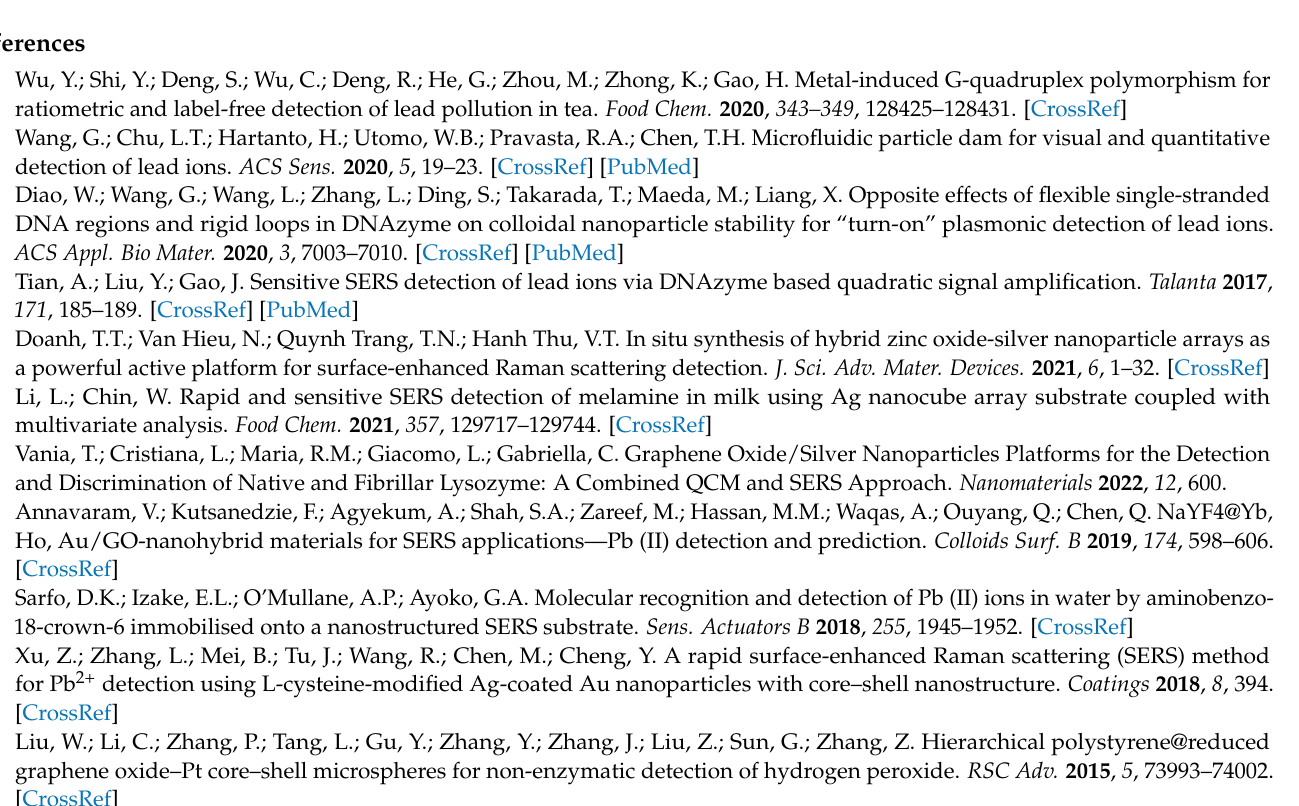
Figure S3: UV absorption spectra of nanocatalytic and analysis system; Figure S4: Optimization of reaction conditions; Table S1: Comparison of the nanocatalysis of AgNO 3 -SF reaction by means of the slope; Table S2: Comparison of methods reported to detect Pb 2+ ; Table S3: The influence of interfering substances on the determination of Pb 2+